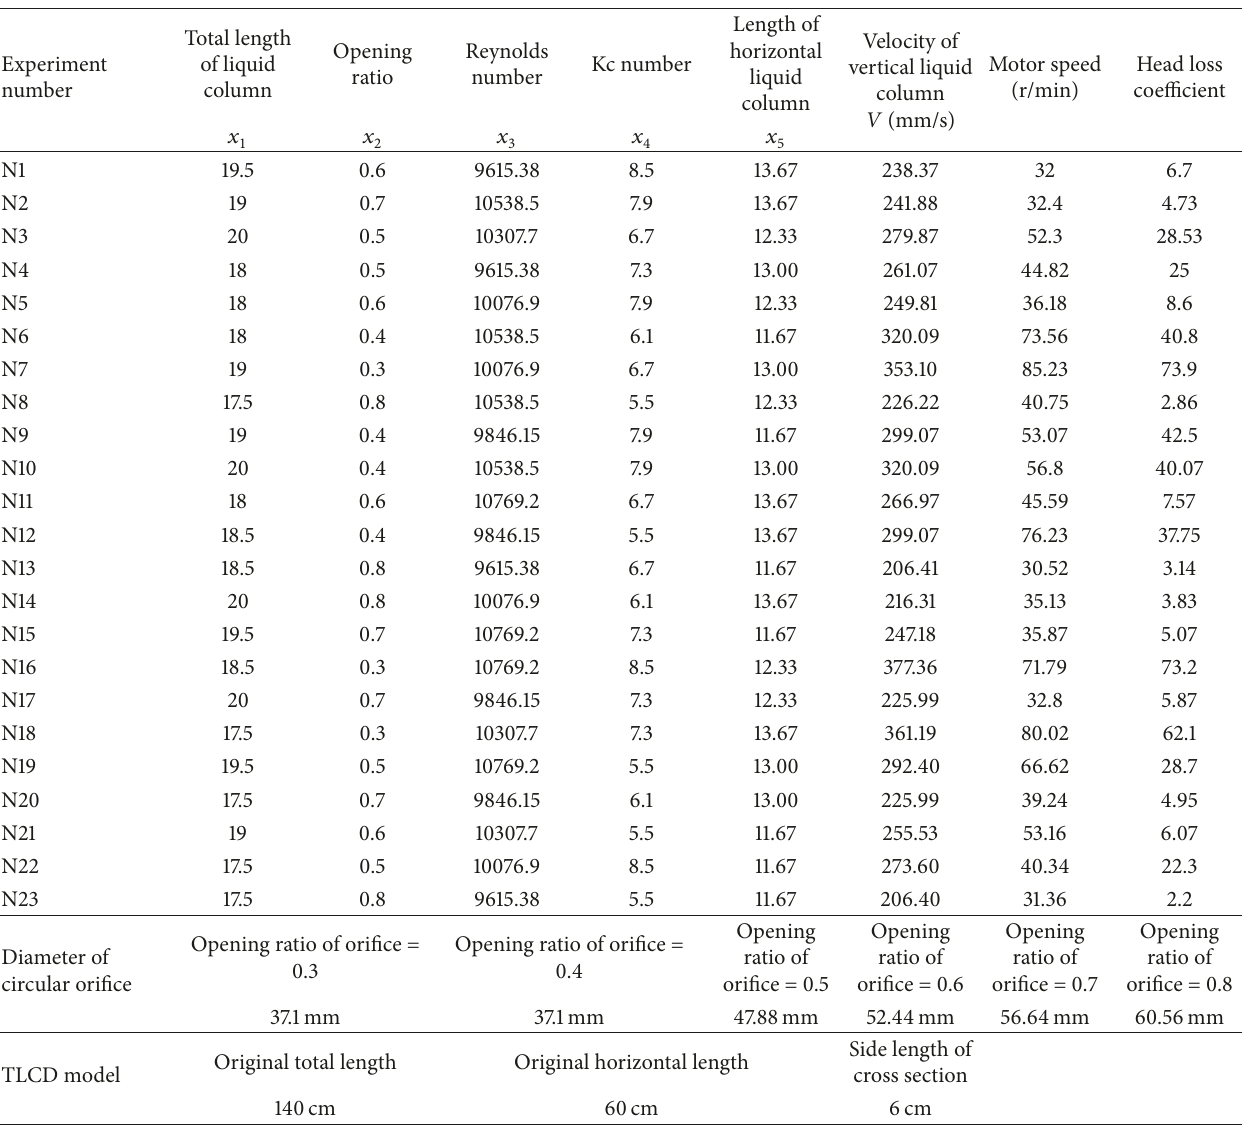
Table 1: Experimental scheme and measured